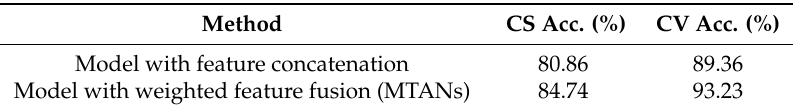
Table 4. Performance comparison between a model with feature concatenation and a model with weighted feature fusion on the NTU RGB+D